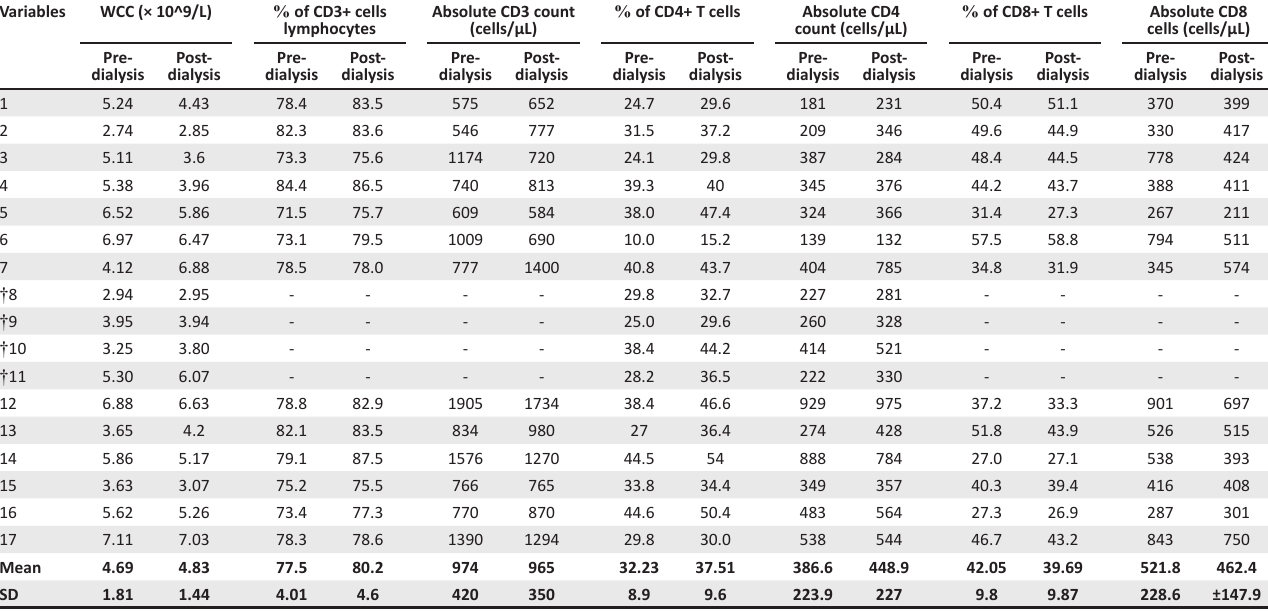
TABLE 4: Measured parameters of the study participants. † Variables